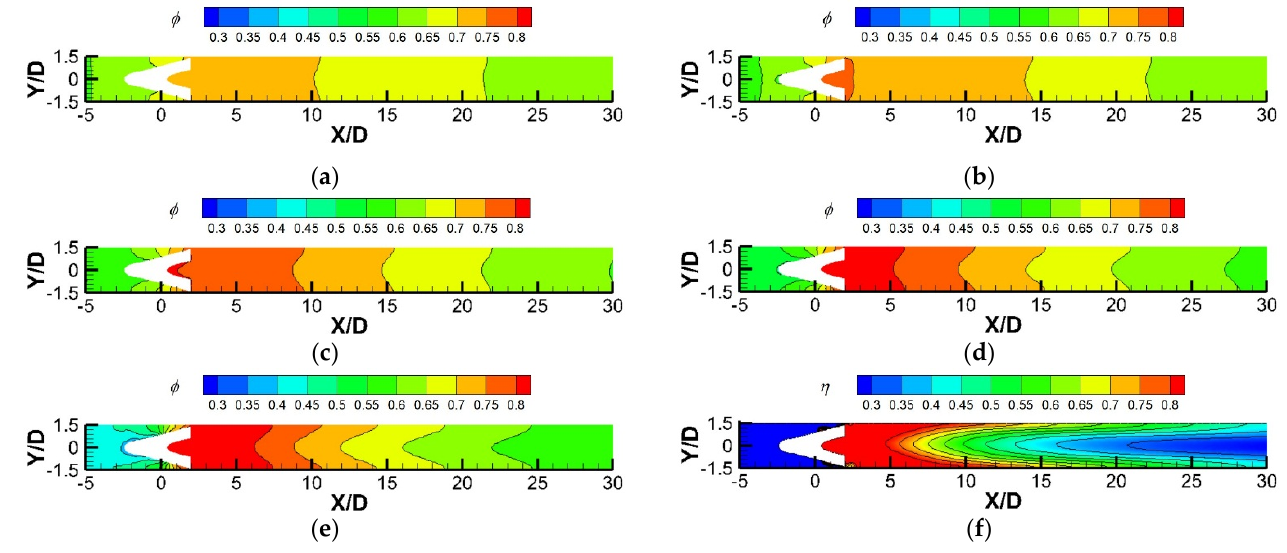
Figure 14. Local overall cooling effectiveness over the wall surface for the CRA2 hole at M = 1.5. ( a ) Bi = 0.026; ( b ) Bi = 0.065; ( c ) Bi = 0.13; ( d ) Bi = 0.26; ( e ) Bi = 0.65; ( f ) adiabatic.